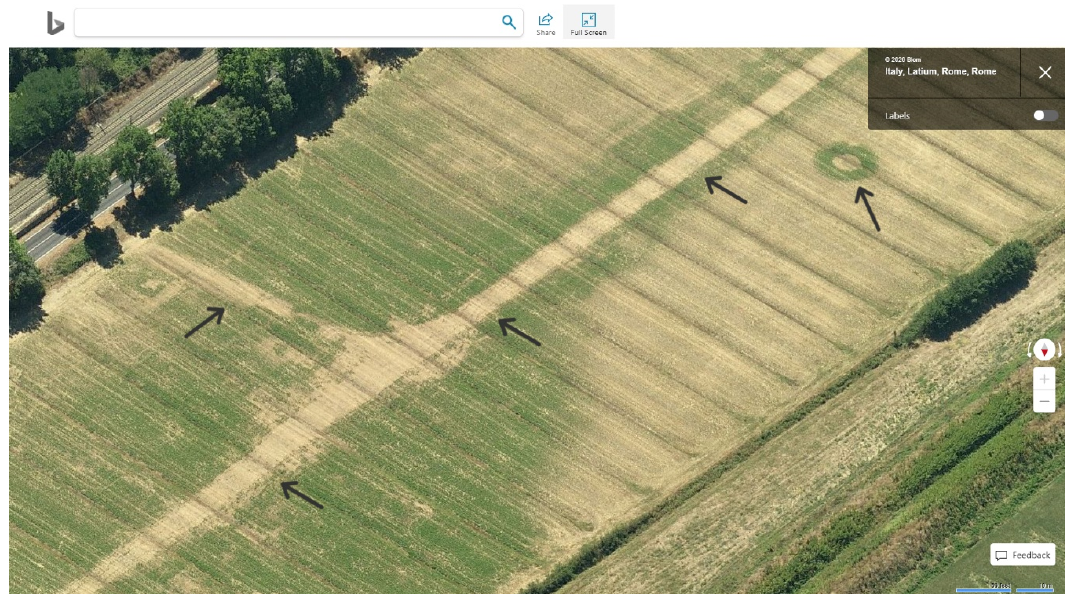
Figure 7. Example of archaeological cropmarks with three positive detections. The light-coloured strip (negative cropmark) bordered by darker positive cropmarks, traversing diagonally from upper right to lower left, is a part of the ancient Via Salaria, with a side road and other structures (see black arrows). These have been reported by Quilici & Quilici Gigli, 1980 [53] and Hyppönen, 2014 [58] from other optical remote sensing data, and by Stewart, 2017 [15] from SAR data. The Microsoft product screenshot is reprinted with permission from Microsoft Corporation.